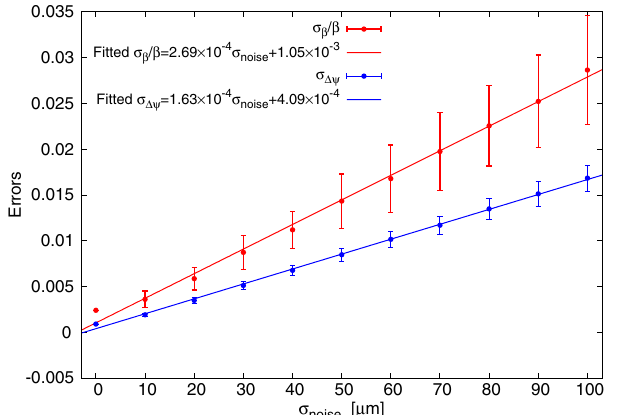
FIG. 14. Estimation of rms errors (cid:3) (cid:6) =(cid:6) and (cid:3) with various (cid:2) c . The estimation at each noise level random noise levels (cid:3) noise (cid:3) is made by repeating the measurement of (cid:6) and (cid:2) c 500 noise times with white Gaussian random noises added to each BPM. The error bars reflect the standard deviations at corresponding noise levels.